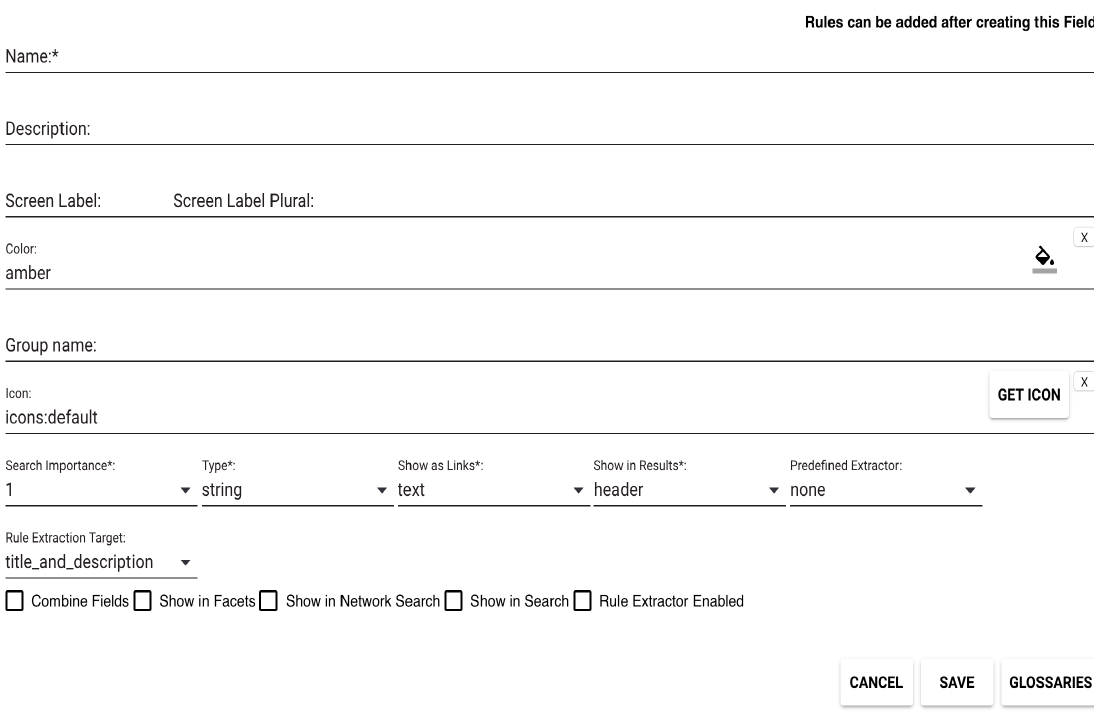
Figure 2. A form that allows the user to define/customize